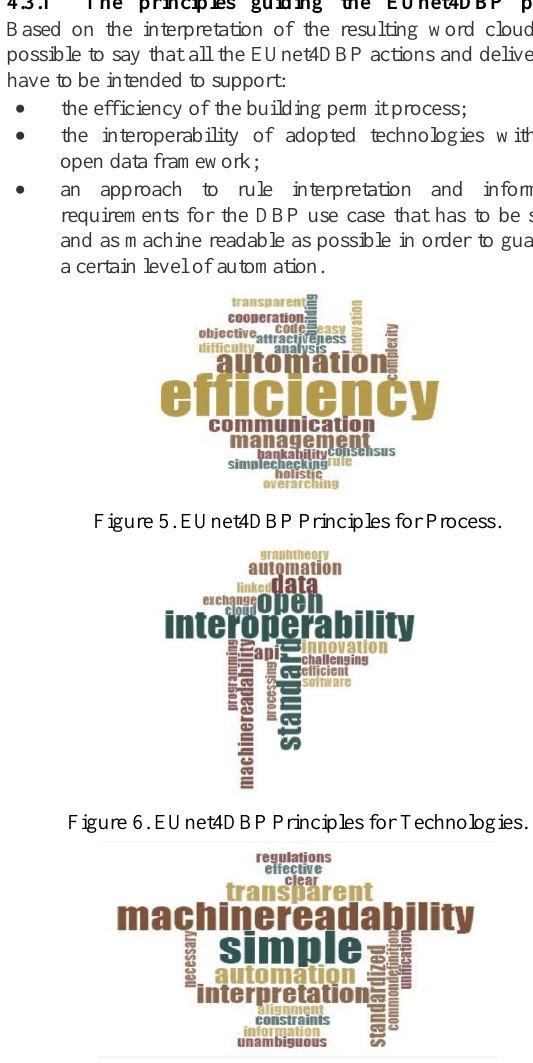
Figure 7. EUnet4DBP Principles for Rules and Regulations.